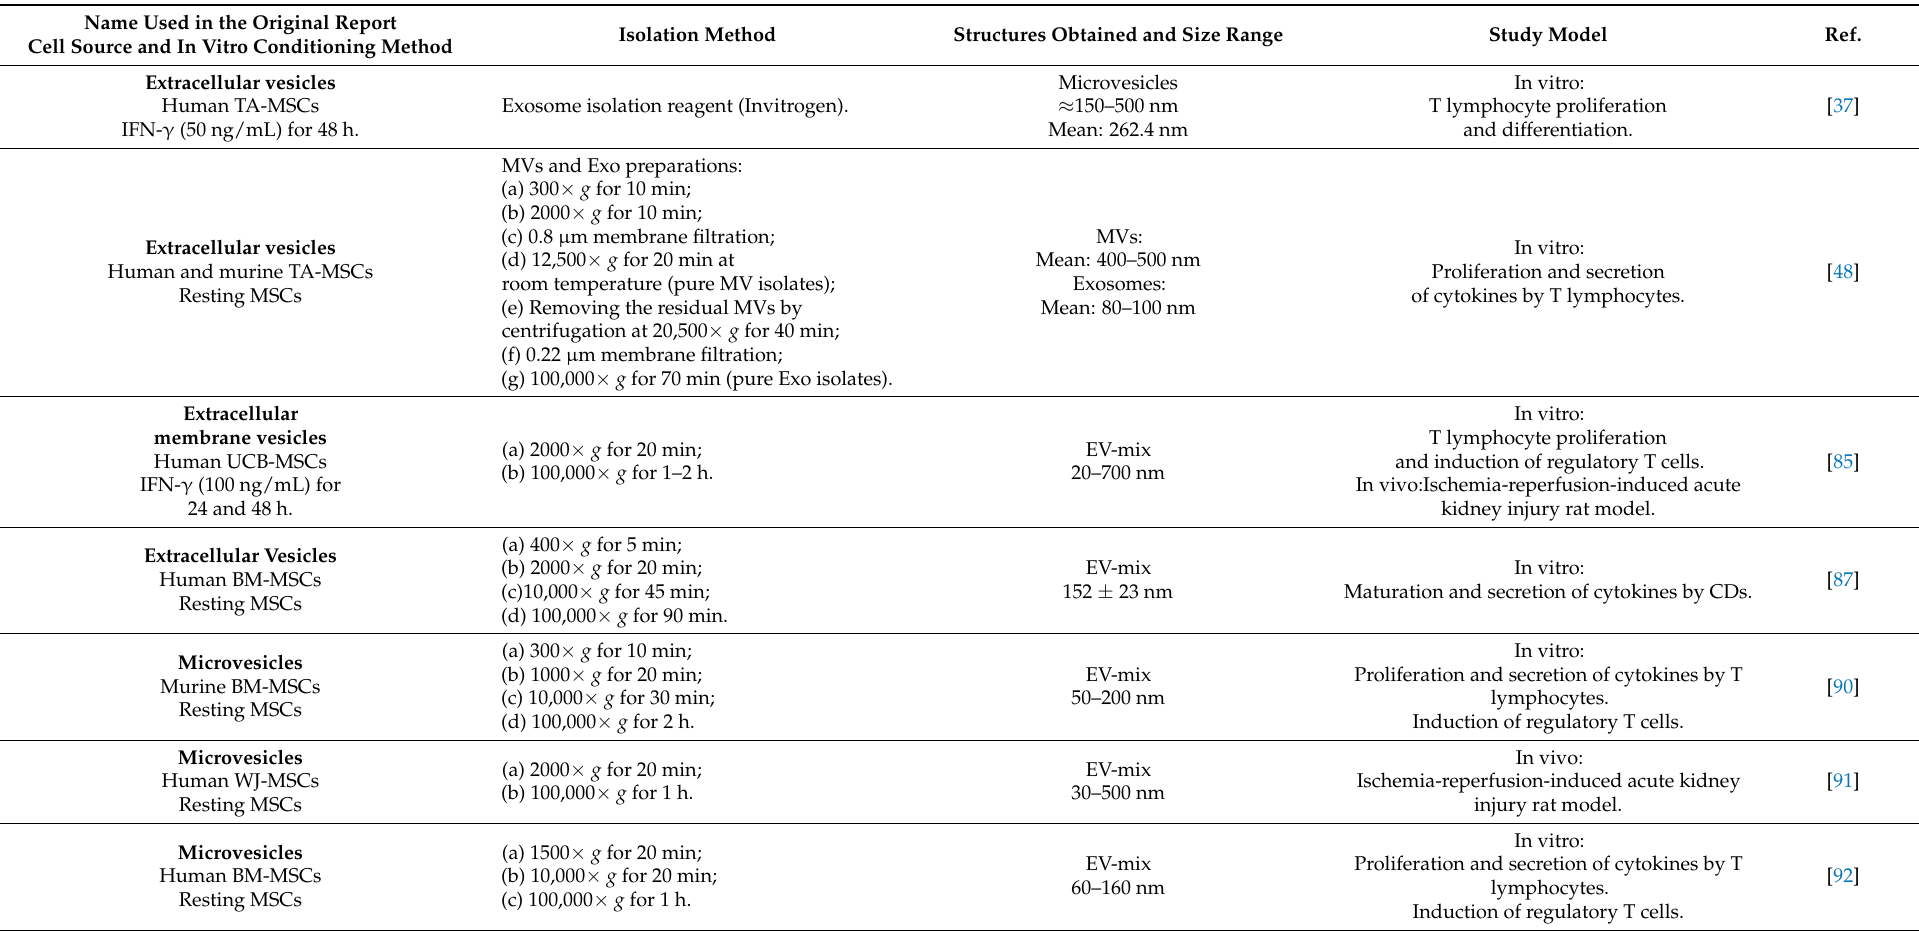
Table 1. Isolation method used and type of EVs